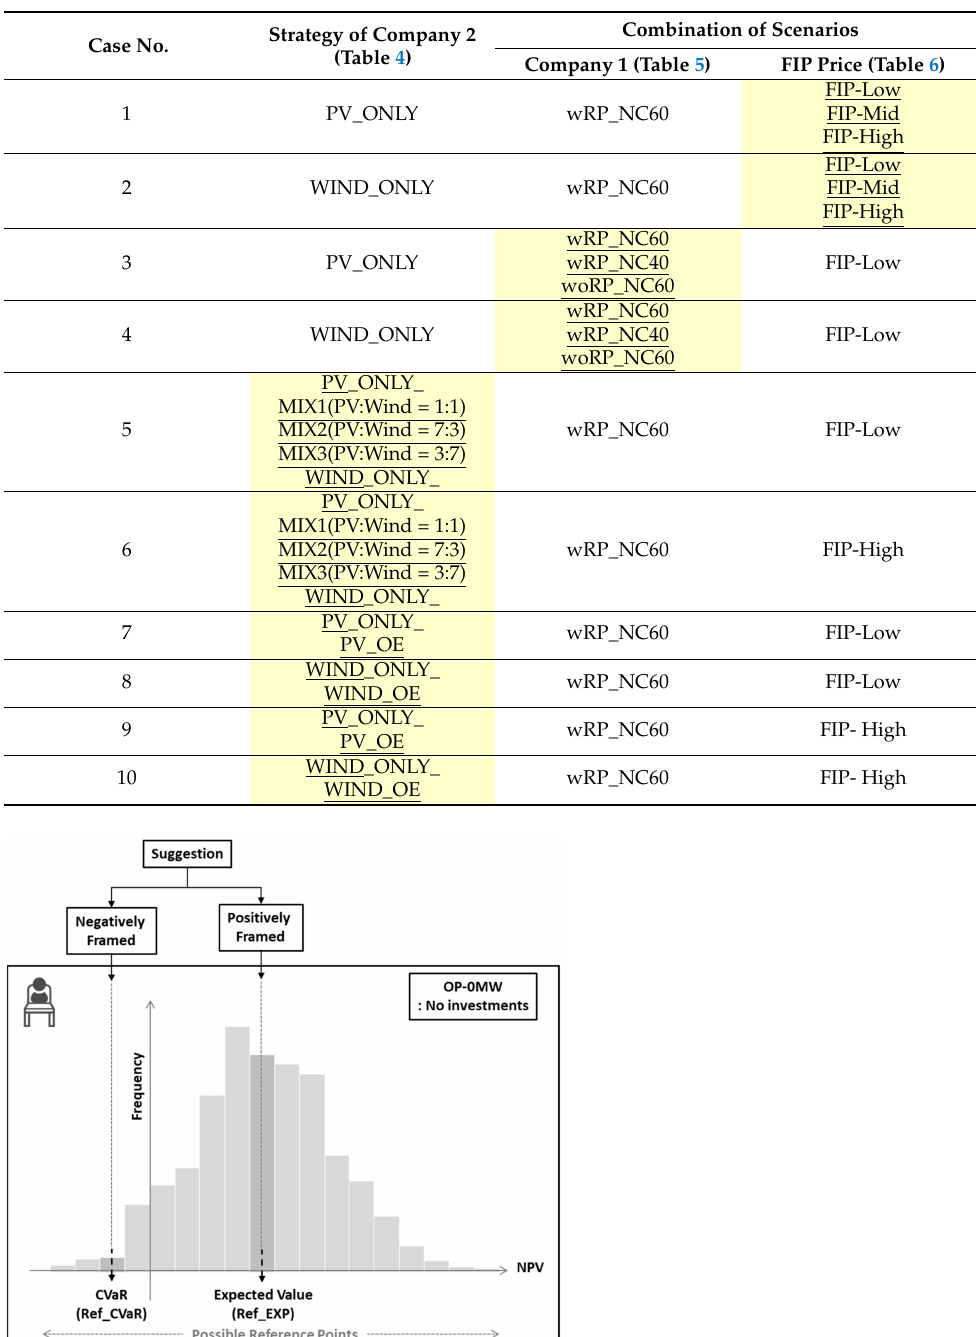
Table 8. Summary of study cases.